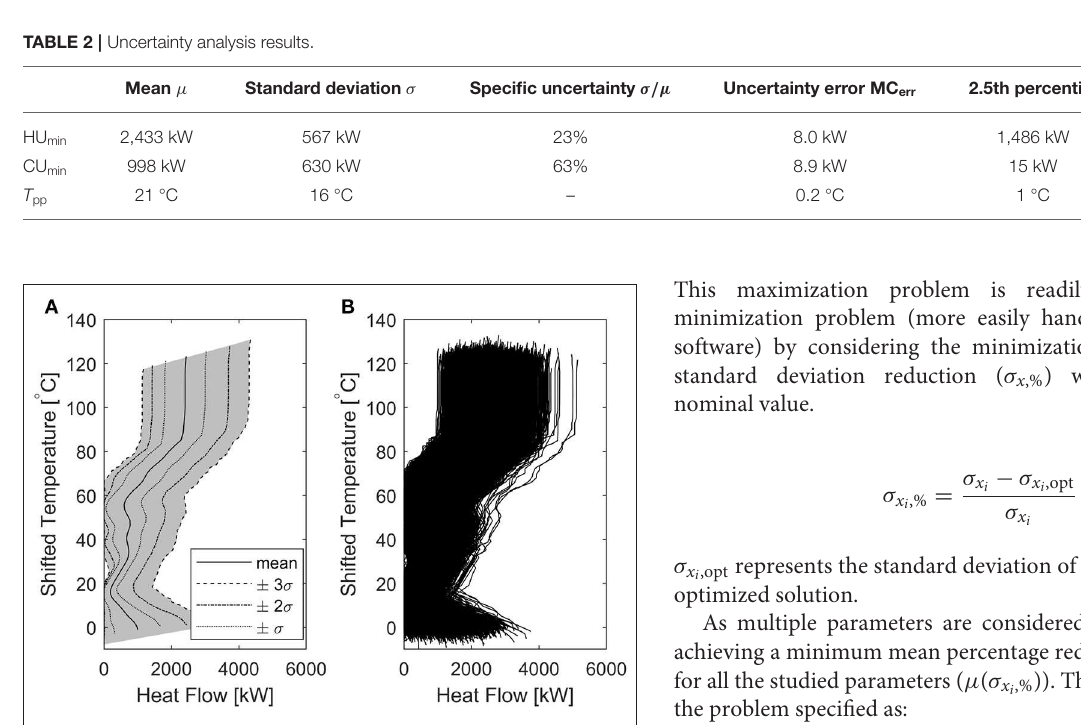
FIGURE 4 | Grand Composite Curve considering uncertainties. (A) approximate probability area for the GCC, (B) aggregated GCC resulting from the N 5,000 =